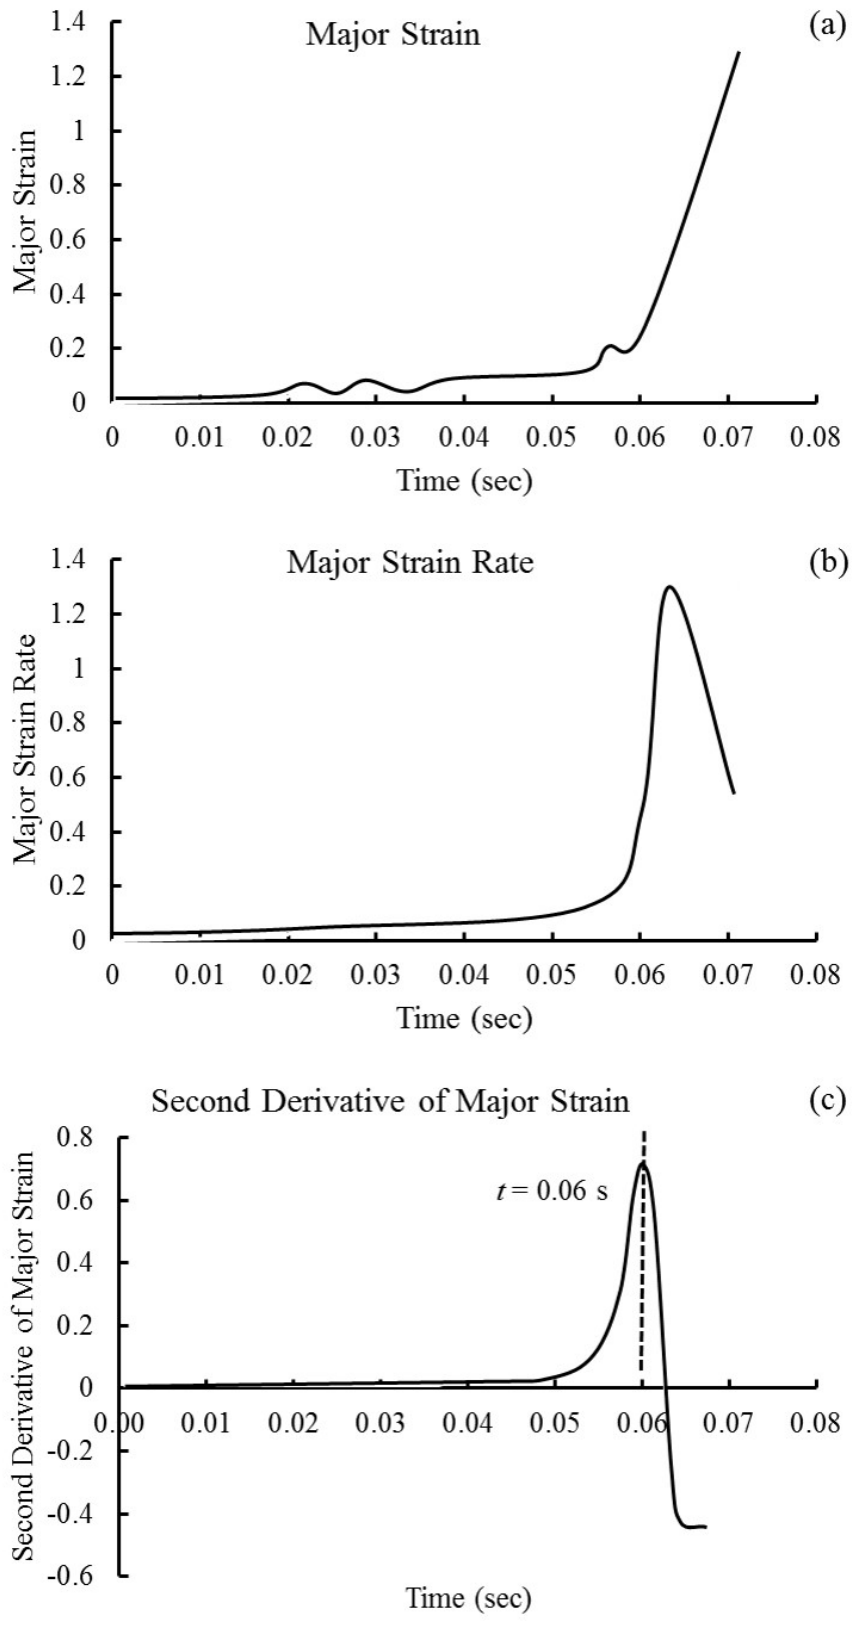
Figure 4. Rupture time estimation process in the specimen: ( a ) major strain history data, ( b ) first derivative of the major strain history data, ( c ) second derivative of the major strain history data.